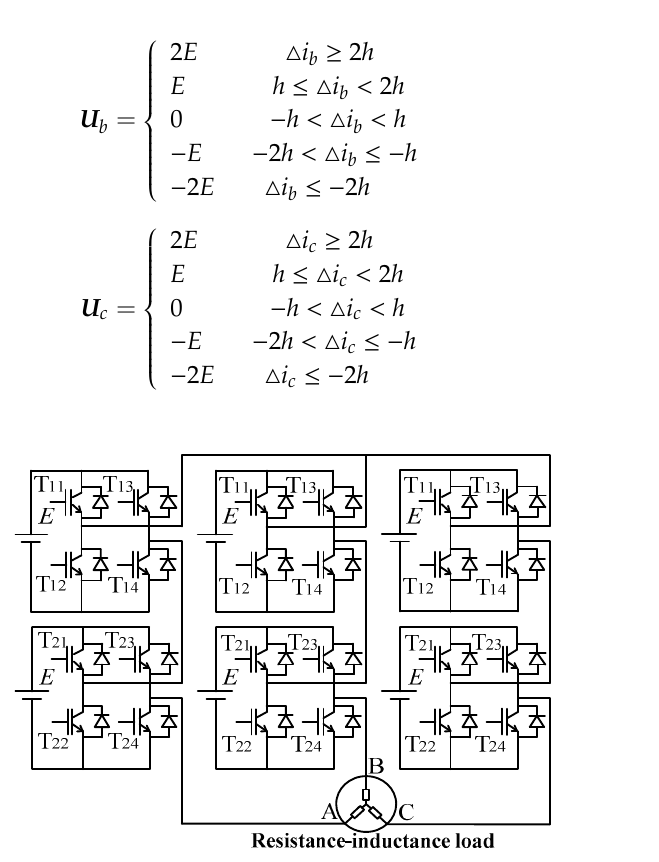
Figure 1. Topology of 2-class cascaded H-bridge multilevel inverter.